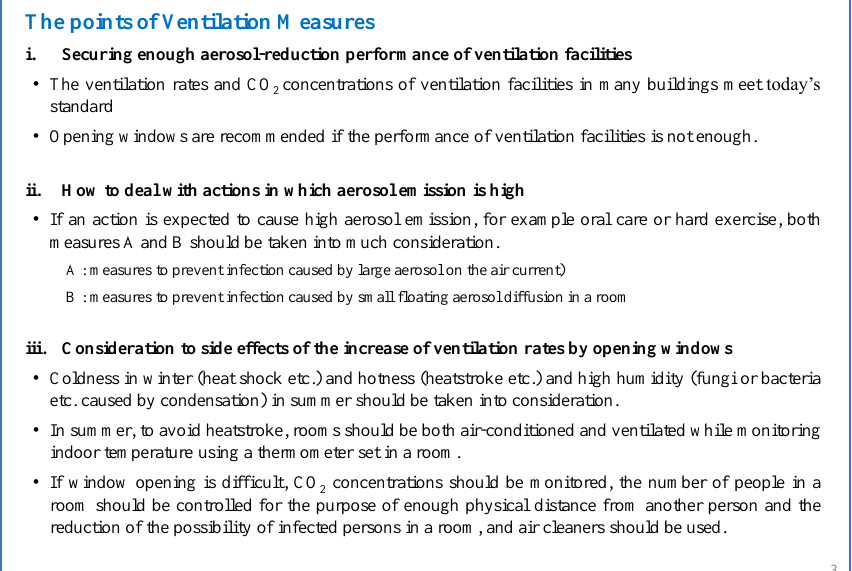
Figure 10. The points of effective ventilation measures.